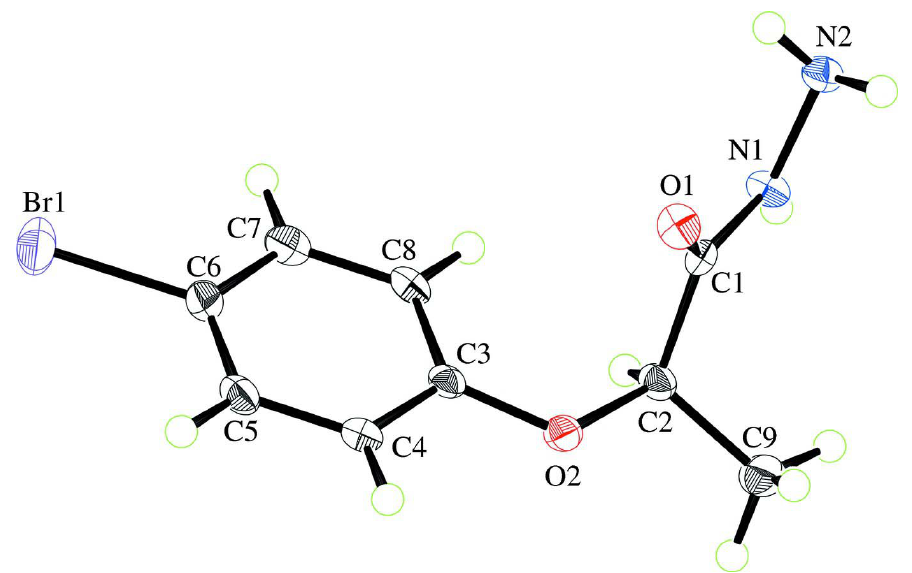
Figure 1 The molecular structure of (I) showing the atom labelling and displacement ellipsoids drawn at the 50% probability